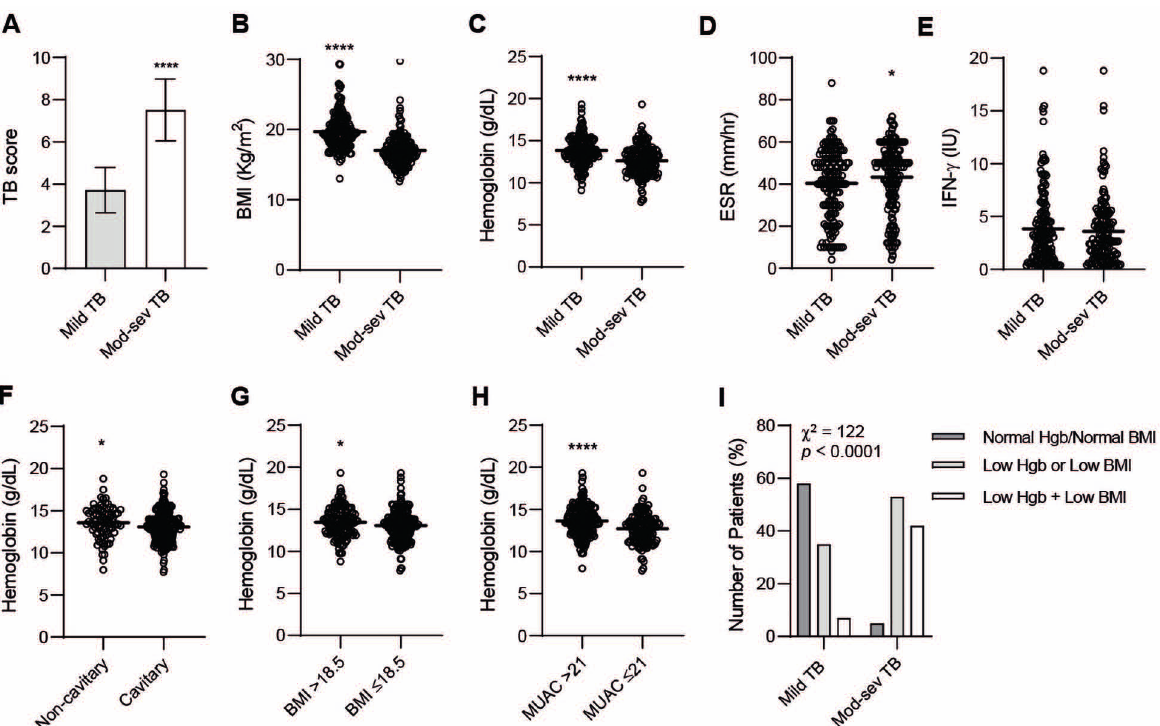
Figure 1. Baseline variables in TB patients with mild versus moderate-severe disease including ( A ) clinical TB score, ( B ) BMI, ( C ) blood Hb, ( D ) ESR, and ( E ) IFN- γ , and blood Hb levels in TB patients based on ( F ) chest X-ray findings, ( G ) BMI, or ( H ) MUAC. Combined blood Hb and BMI are shown in ( I ). Data (mean or mean ± SD) are presented in bar graphs or scatter plots and were analyzed using an unpaired t -test, p < 0.05 *, p < 0.0001 ****. Data in ( I ) were analyzed using a Chi-square